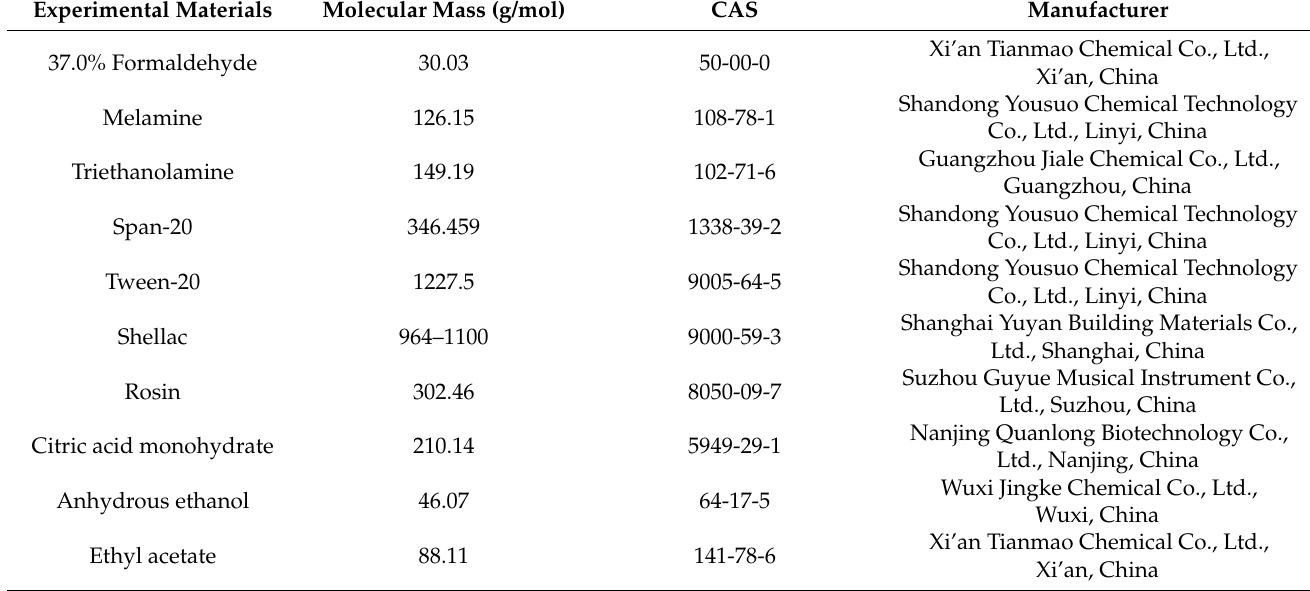
Table 1. List of raw material information for the experiments.